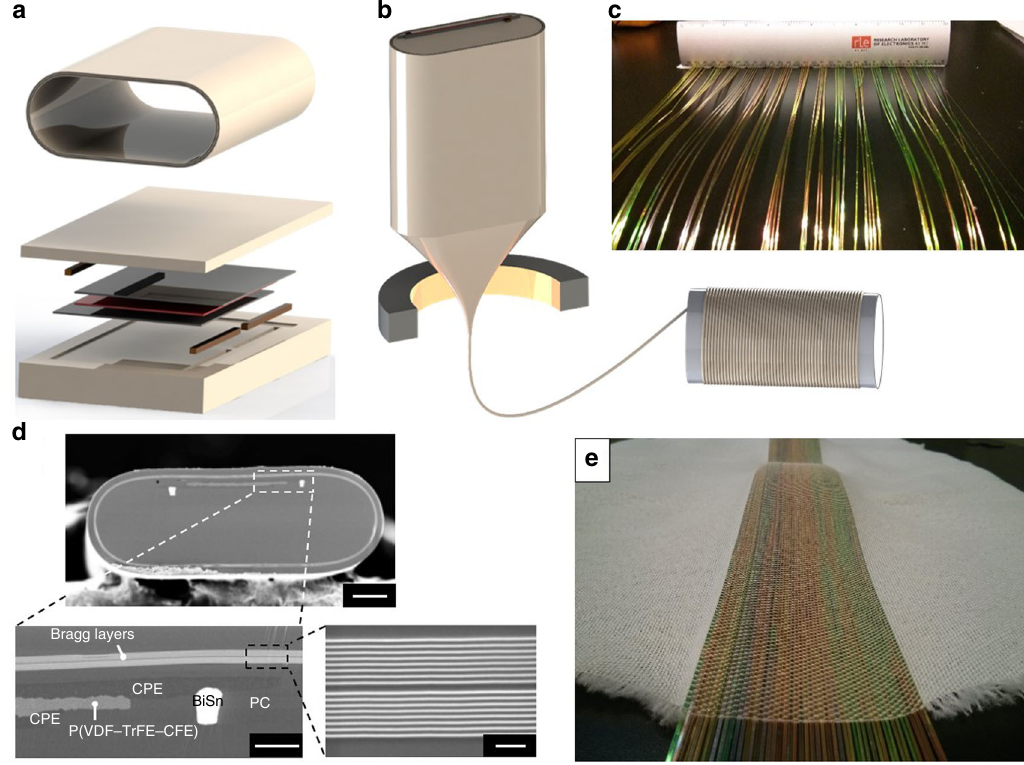
Fig. 1 Fabrication of electrostrictive fi bres. a Schematic of the preform assembly for a multimaterial electrostrictive fi bre. A P(VDF-TrFE-CFE) layer (red) is assembled with CPE polymer electrodes (black), Bi – Sn electrodes (brown) and a PC cladding (beige), and consolidated. The surrounding shell incorporates a multilayer As 25 S 75 /PC structure (top). b Schematic of the preform-to- fi bre draw process. c Array of fl exible electrostrictive fi bres shows colored re fl ections via the Bragg effect. d SEM micrographs of the overall structure and close-up of a multimaterial electrostrictive fi bre and Bragg layers. Scale bars for top, bottom left, and bottom right are 100, 20, and 2 μ m, respectively. e We demonstrate the capability to integrate our fi bre MEMS into the textile using conventional weaving